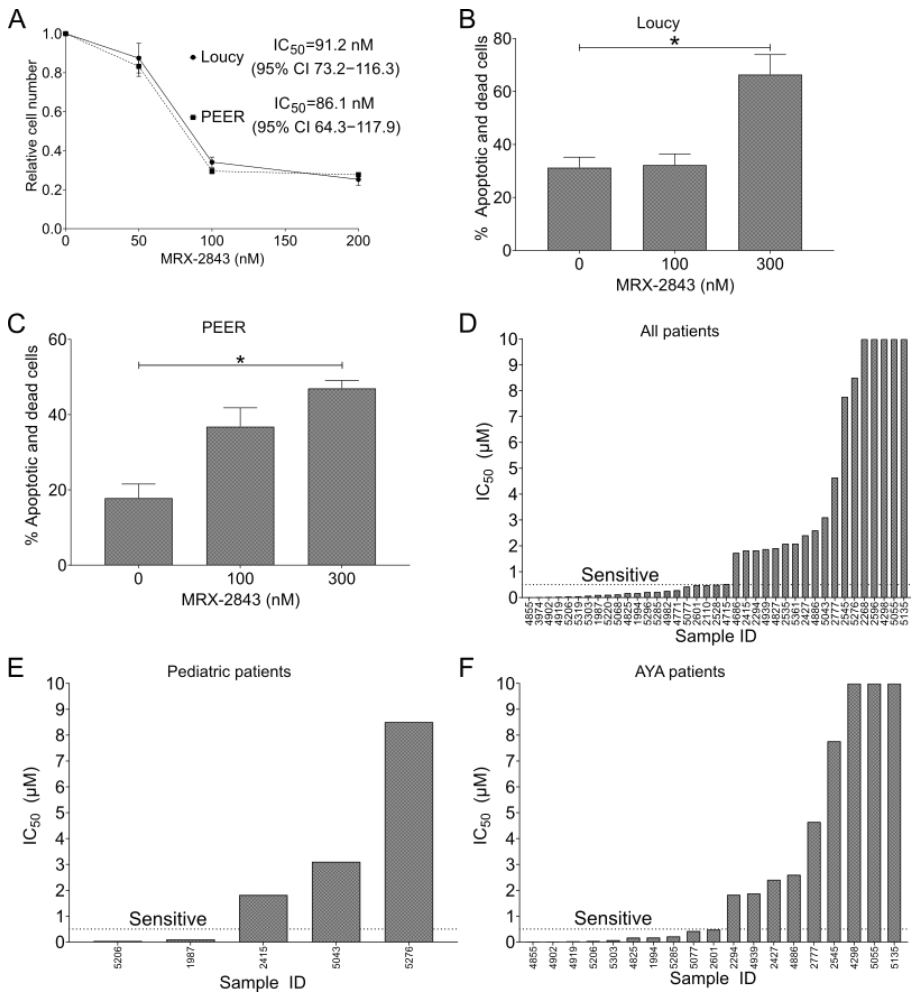
Figure 3. MERTK inhibition has functional antitumor effects in ETP-ALL cell lines and T-ALL patient samples. ( A ) Loucy or PEER cells were plated in triplicate at 20,000 cells/well and cultured for 24 h; then, they were treated with vehicle (DMSO) or MRX-2843 at the indicated concentrations for an additional 48 h. After treatment, cells were stained with Presto Blue reagent, fluorescence was measured, and cell numbers were calculated relative to the DMSO control. IC 50 values were determined by nonlinear best-fit regression analysis. Mean values ± SEM were derived from three independent experiments. ( B , C ) Loucy ( B ) or PEER ( C ) cells were plated at 300,000 cells/well and cultured for 24 h, and then treated with vehicle or MRX-2843 at the indicated concentrations for an additional 48 h. After treatment, cells were stained with PO-PRO-1 iodide and propidium iodide dye uptake was assessed by flow cytometry. Mean values ± SEM were derived from 3–4 independent experiments (* p < 0.05, one-way ANOVA). ( D – F ) T-ALL patient samples were cultured with UNC2025, a close analogue of MRX-2843, and relative cell numbers were assessed using MTS reagent. ( E ) Patient samples obtained from patients aged 0–18 years. ( F ) Patient samples obtained from patients aged 15–39 years. Abbreviations: AYA—adolescent and young adult.